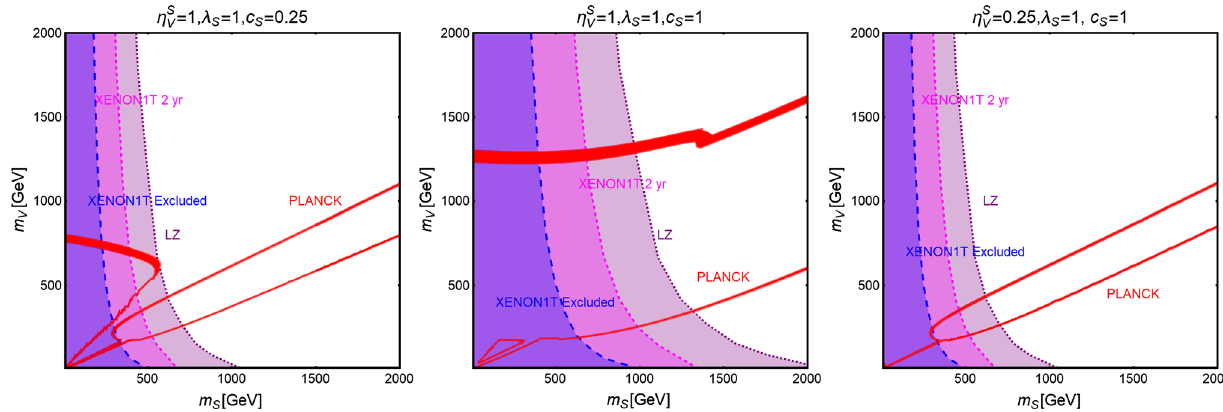
Fig. 11 The same as Fig. 9 for a vector DM with scalar mediator, i.e., trading λ S χ , m χ with η S